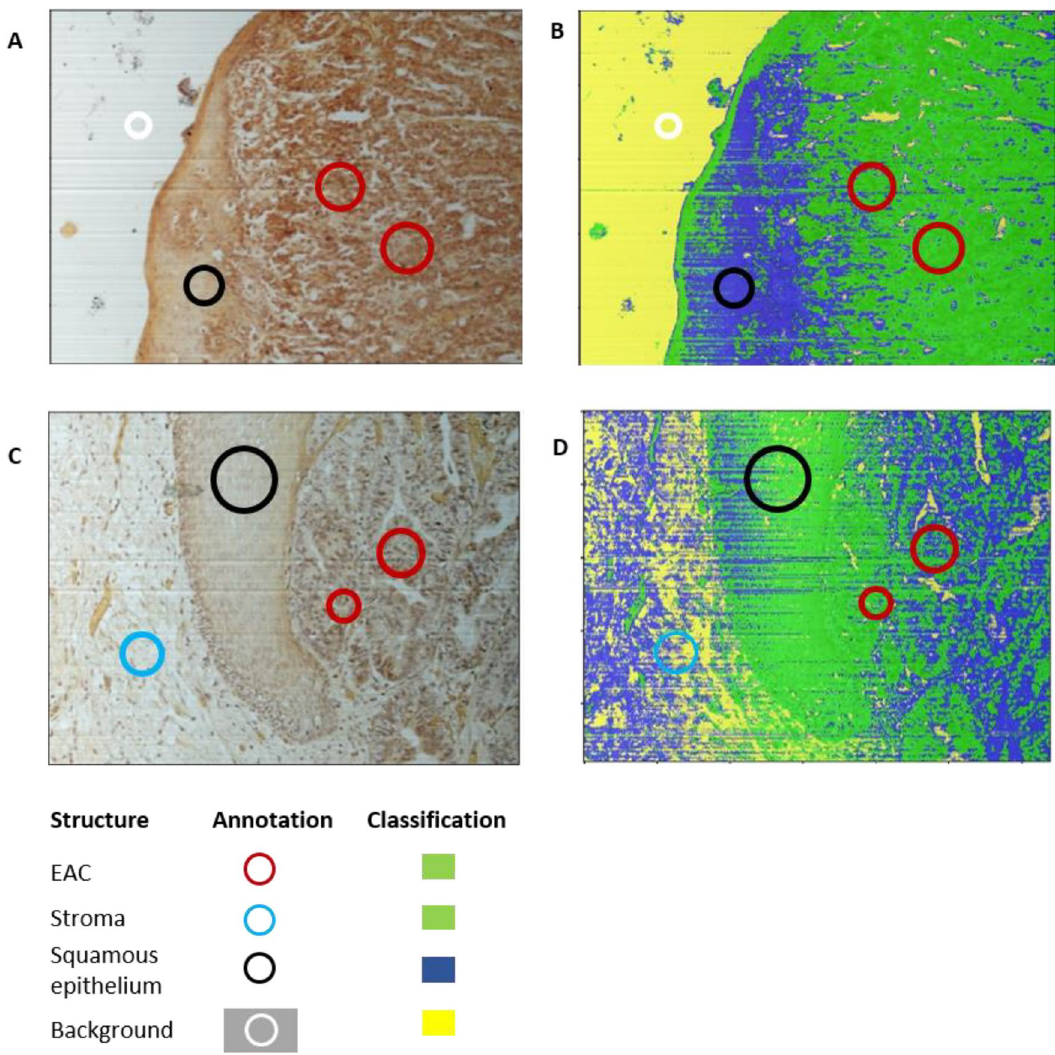
Figure 5. Visualization of the classification results. RGB image of an image ( A ) and the classification results visualized in ( B ). The RGB image ( C ) was classified and the classification results were visualized in, representing a visual misclassification, e.g. squamous epithelium was classified as tumor stroma ( D